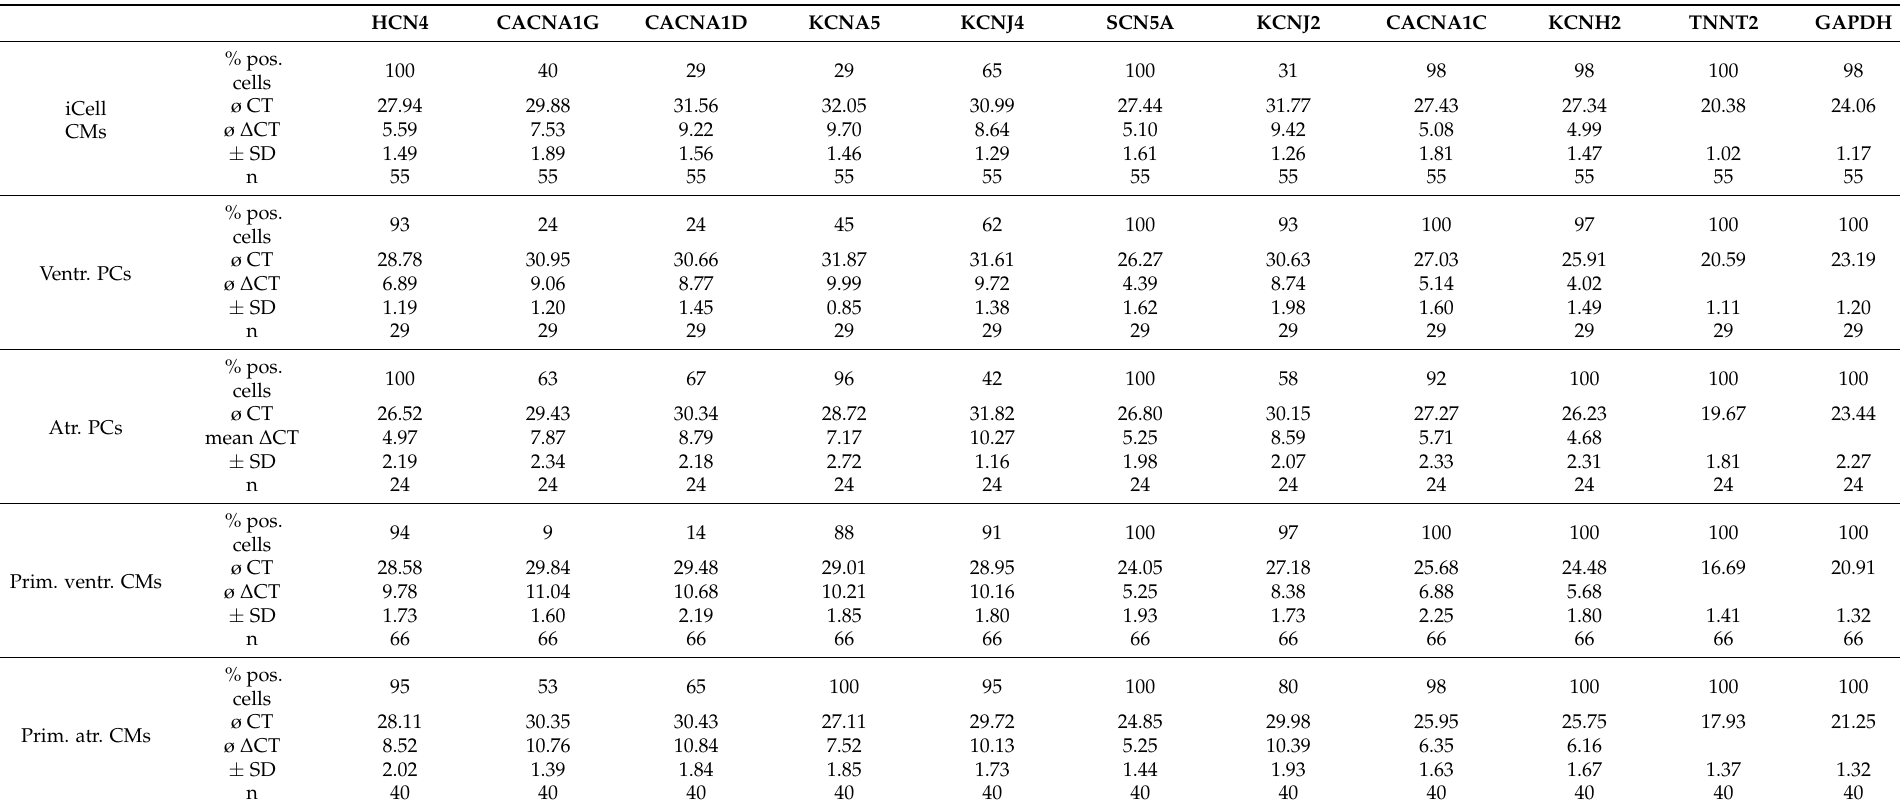
Table 3. Results of single-cell RT-qPCR. Besides the percentage of positive cells (% pos. cells) and the number of investigated cells (n), also mean (ø) CT values and, mean (ø) ∆ CT values are listed. ∆ CT values are CT values normalized to the mean expression of TNNT2, and GAPDH of the respective cell group. For details see Methods section. Standard deviations (SD) are identical for CT and ∆ CT values because the difference between the two values is a constant. HCN4